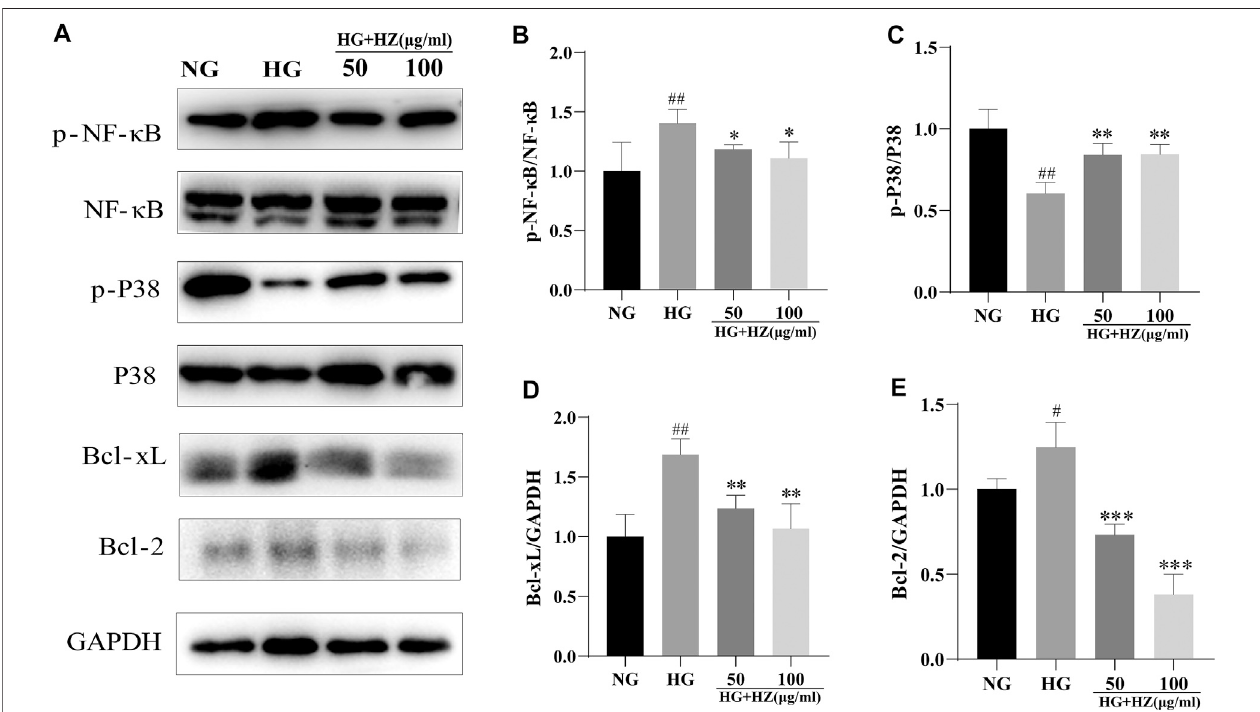
FIGURE6| EffectofHZQMYonproteinexpressionofP38andNF- κ BsignalpathwaysinHRCECs. (A) p-NF- κ B,NF- κ B,p-P38,P38,BCL-XL,BCL-2andGAPDH weremeasured bywestern blot. (B) Theexpression ofp-NF- κ Bwasanalyzed. (C) The expression ofp-P38 wasanalyzed. (D) Theexpression ofBCL-XL wasanalyzed. (E) TheexpressionofBCL-2wasanalyzed. ## and ### indicate p < 0.01and p < 0.001comparedwithNGgroup. ** and *** indicate p < 0.01and p < 0.001comparedwith HG group. HZ: